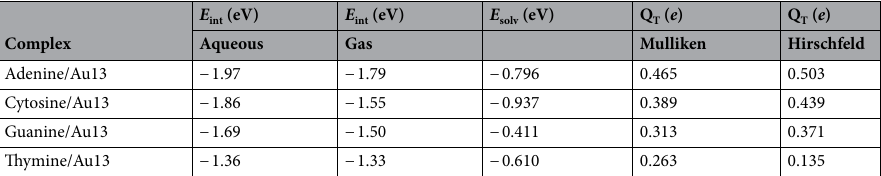
Table 1. The calculated interaction energies in gas and solvent media and solvation energies as well as charge transfer by Mulliken and Hirshfeld methods for nucleobases interacting with Au13